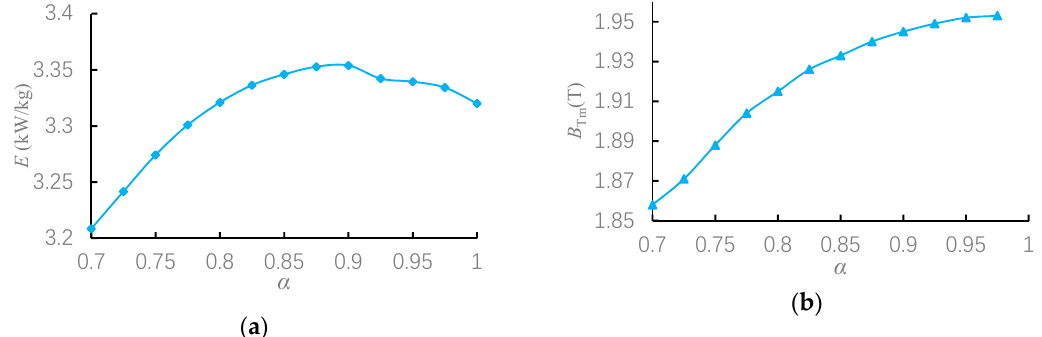
Figure 5. ( a ) Changes of the power density with the polar arc coefficient; ( b ) Changes of the magnetic density at the motor teeth with the polar arc coefficient.